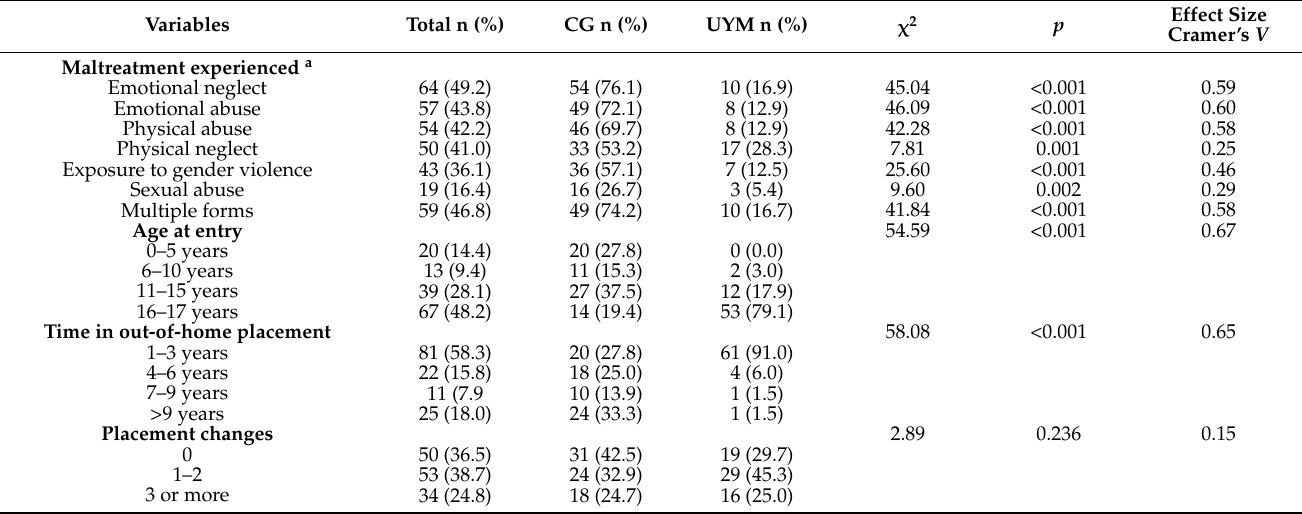
Table 1. Victimization and Child Care Background. Differences between